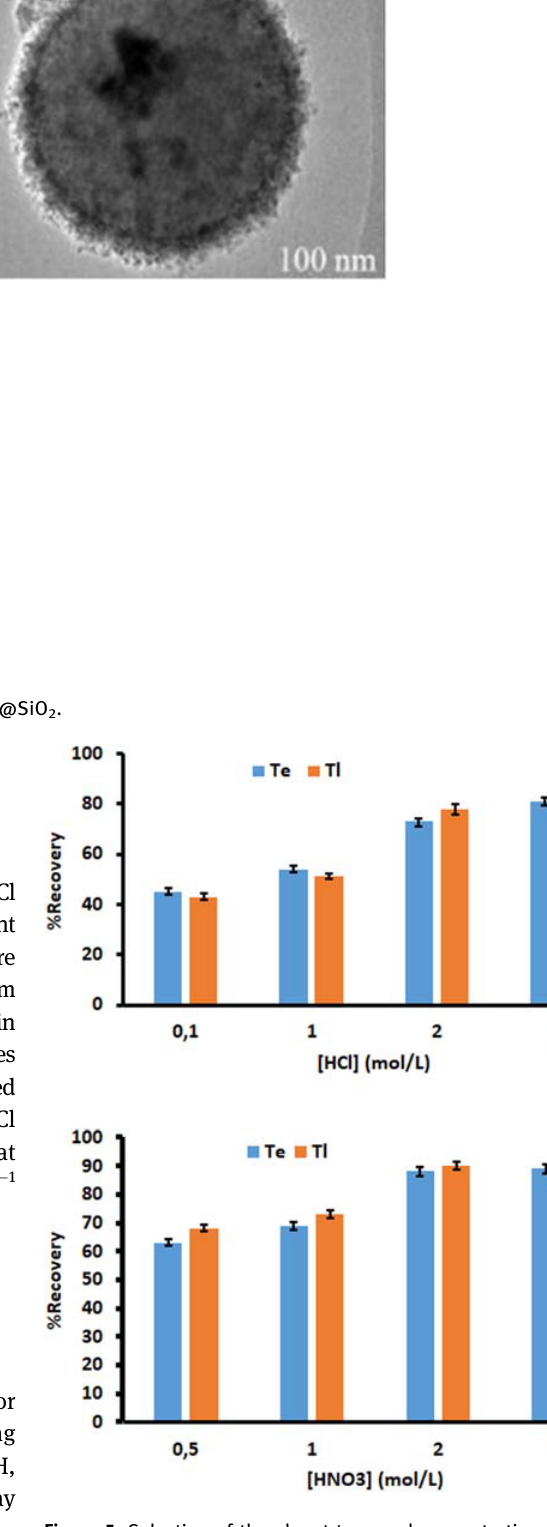
Figure 5: Selection of the eluent type and